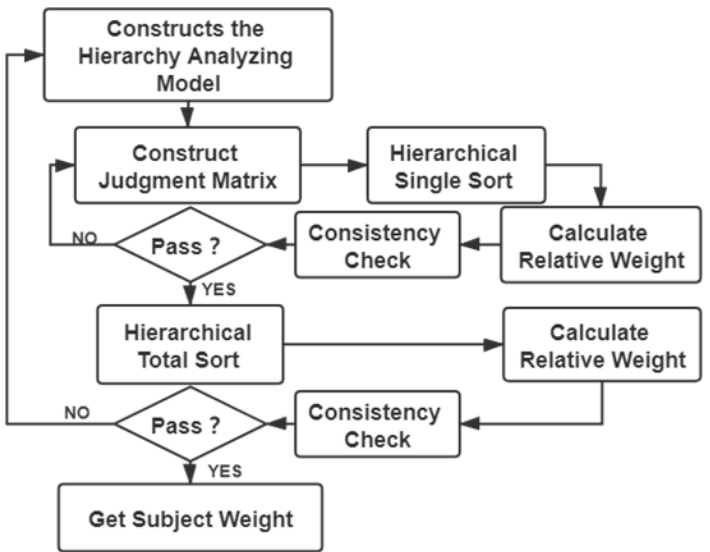
Figure 3. The steps to get subjective weights.